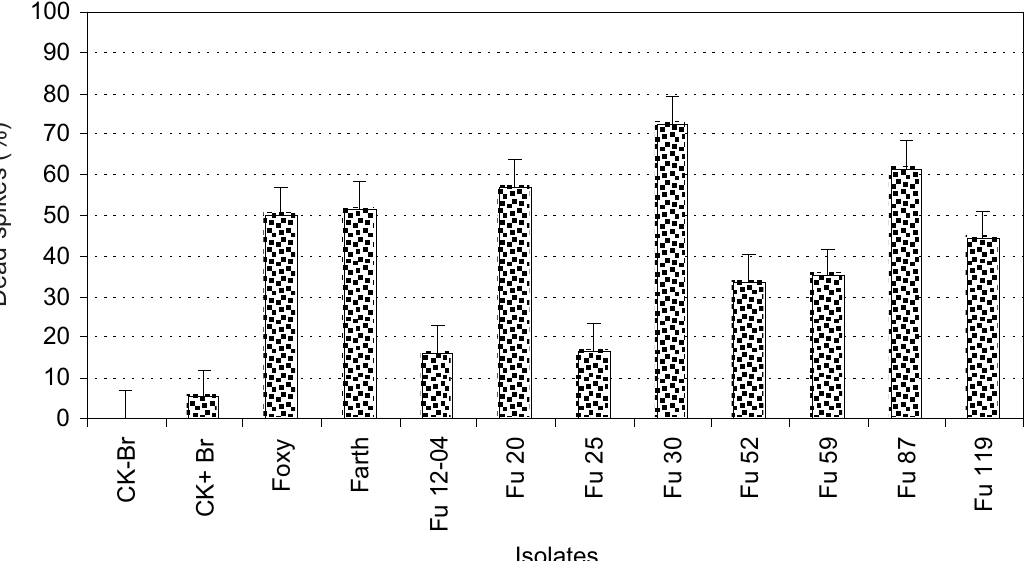
Fig. 2. Effect of pathogenicity tests with the selected most promising Fusarium spp. isolates on broomrape of tomato plants grown in pots. The pots contained Fusarium infested soil.